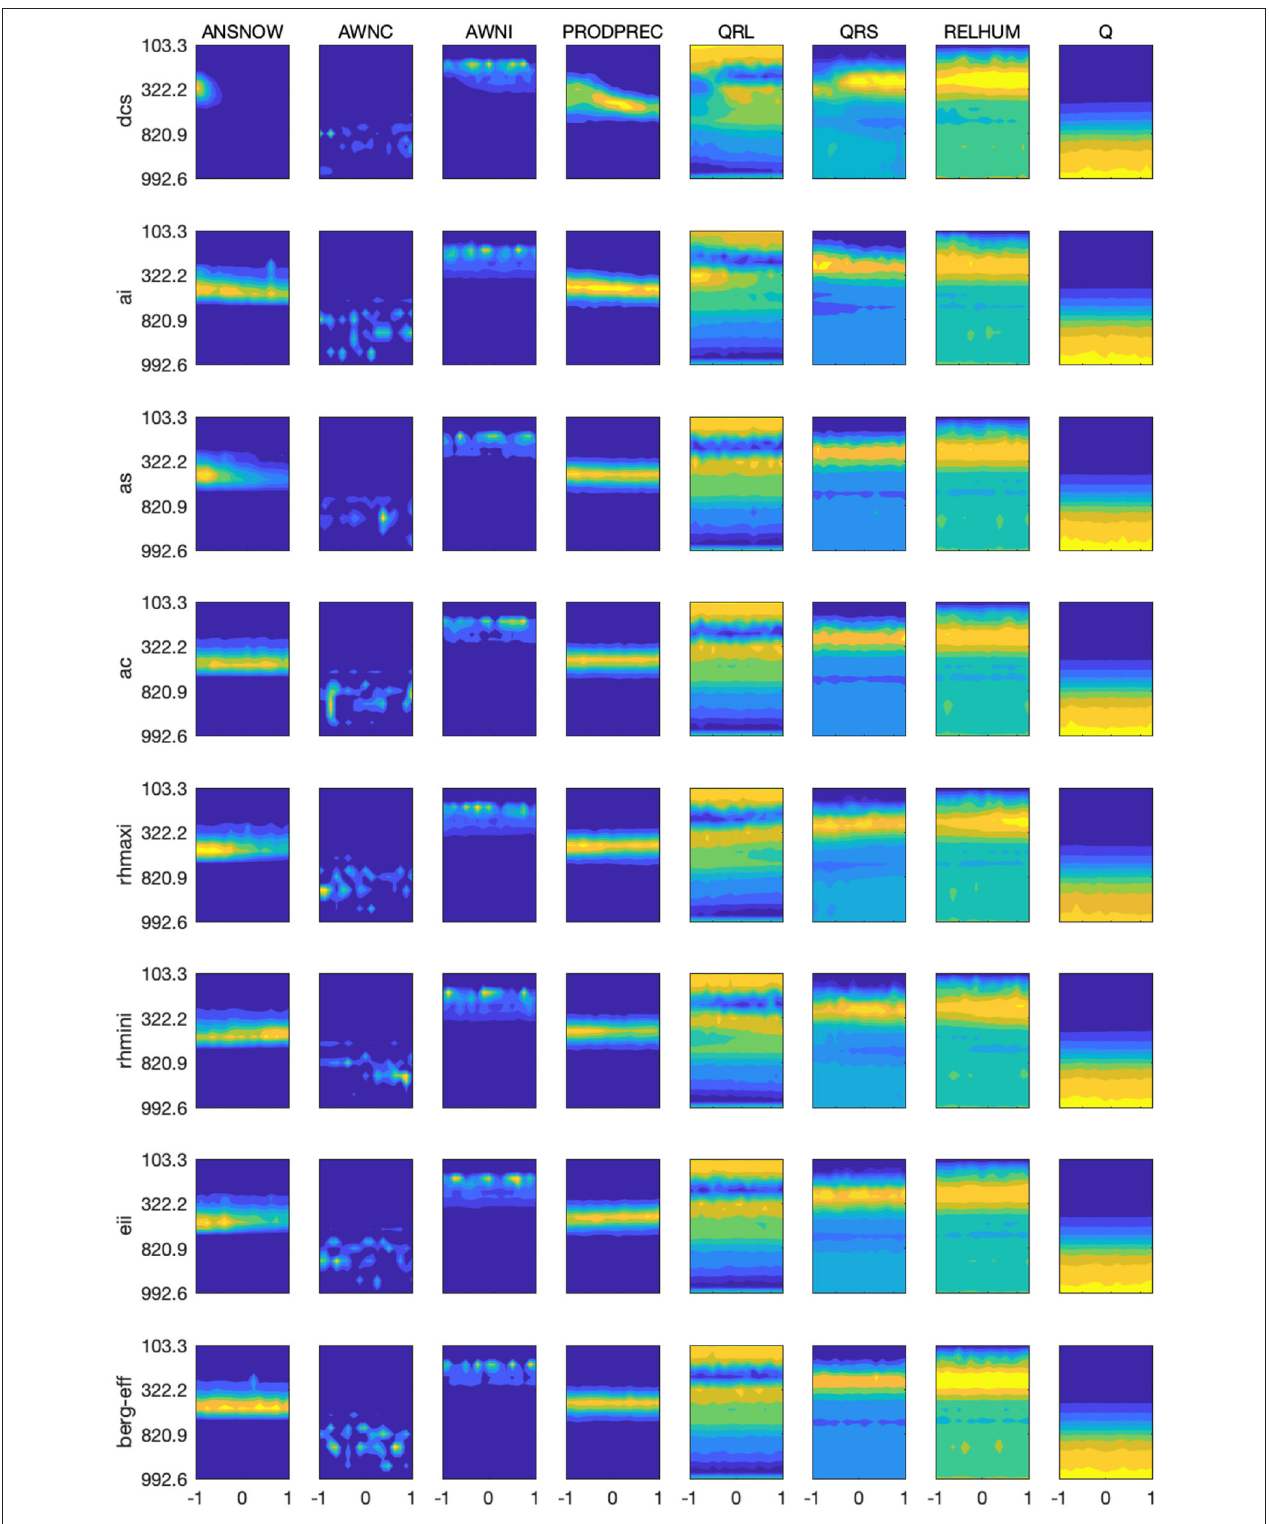
FIGURE 10 | Parameter perturbation response to the vertical distribution of snow concentration (ANSNOW), cloud water concentration (AWNC), ice concentration (AWNI), precipitation production (PRODPREC), longwave heating rate (QRL), shortwave heating rate (QRS), relative humidity (RELHUM), and specific humidity (Q).